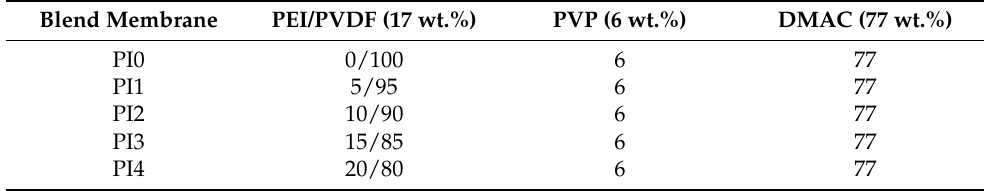
Table 1. PVDF/PEI blend membrane material ratio. Blend